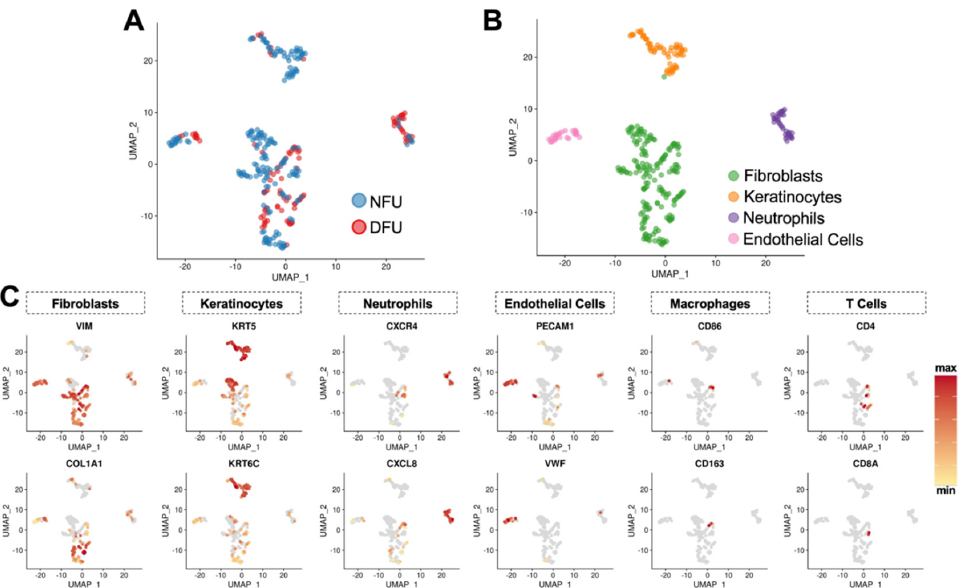
Figure 2. Identification of characteristic wound healing cell subtypes from unsorted populations. ( A ) UMAP embedding of cells clustered independently of experimental group, labeled as either non-diabetic foot ulcer (NFU) or diabetic foot ulcer (DFU). ( B ) UMAP embedding of cells labeled by cell type using the Human Primary Cell Atlas (HPCA) reference dataset and automated annotation tool SingleR. ( C ) Feature plots of cell subtype specific marker genes.